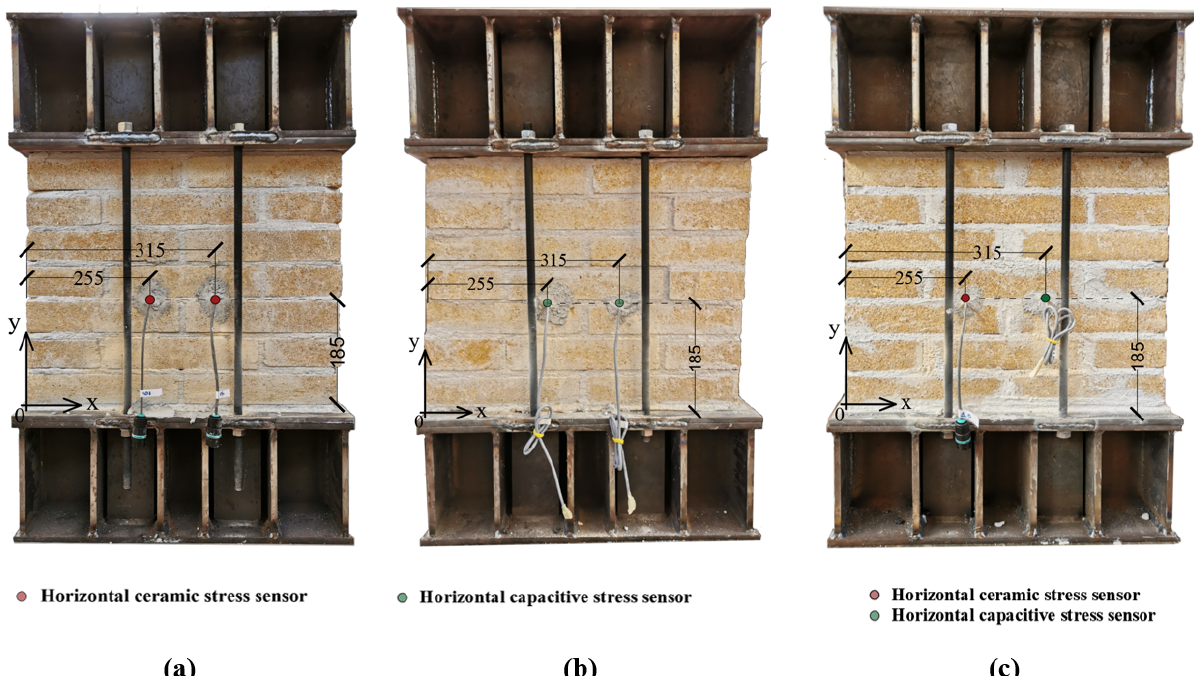
Figure 6. Sensor placement (dimensions in mm) for post-installation system P1: ( a ) pattern with two horizontal ceramic sensors; ( b ) pattern with two horizontal capacitive stress sensors; ( c ) pattern with two horizontal stress sensors, i.e., one ceramic and the other capacitive.